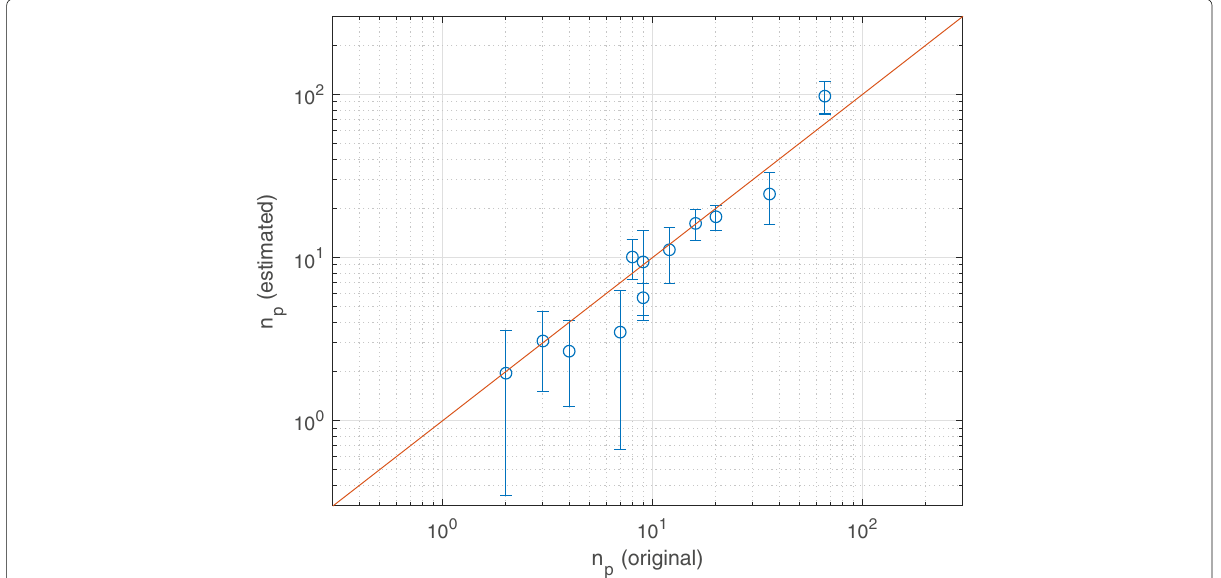
Fig. 3 Accuracy of the proposed nano-metering protocol. Estimated number of particles using the proposed protocol vs the original number of particles. The reported data (dots) refer to the configurations in Table 1; the solid line is the bisector. The error bars on the value of n e p are computed from the variability of D and V tot values (uncertainty quantification, ± 1